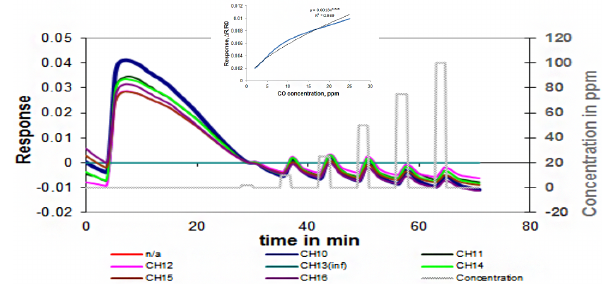
Figure 6. The response of the sensors in Fig. 5 under a 65% RH